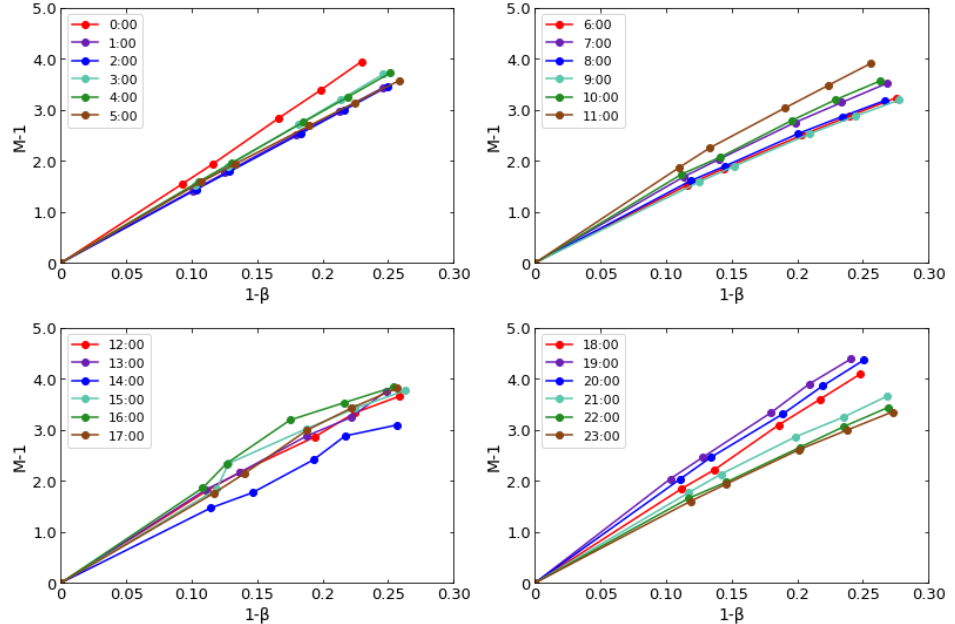
Figure 4. Hourly relationship between the momentum availability factor ( M ) and the farm wind- speed reduction factor ( β ) over the 24 h, computed using the “two-day hourly average” method. Five data points along each line correspond to the five roughness lengths tested, and the gradient of each line corresponds to ζ = ( M − 1 ) / ( 1 − β )